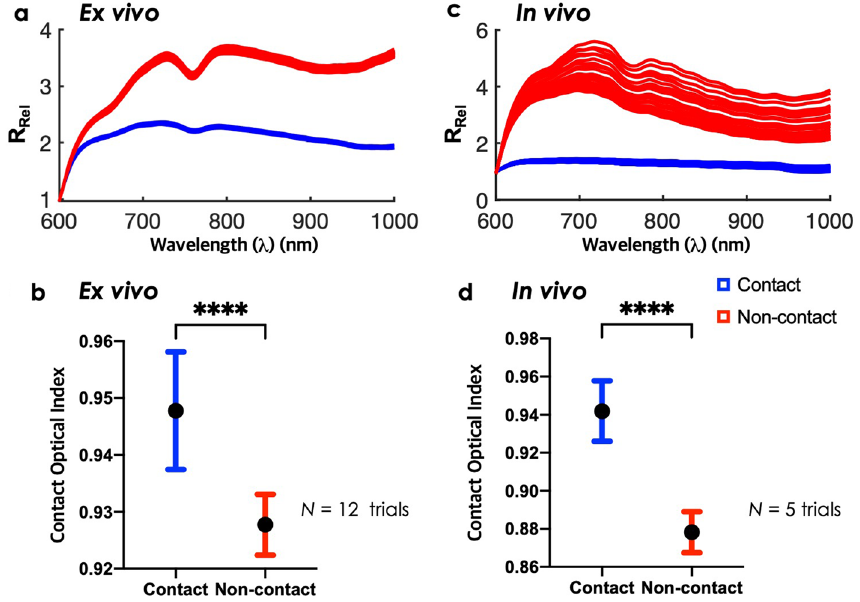
Figure 3. Catheter probe contact assessment ex vivo and in vivo. ( a ) Represents R Rel spectra of ex vivo contact (red) and non-contact (blue) measurements for 10 s. Black dashes denote contact optical index (COI) wavelengths. COI is described as follows: R Rel (764 nm)/ R Rel (730 nm). ( b ) Compares recorded COI between contact and non-contact. Bars are presented as mean and standard deviation (****P < 0.0001). ( c , d ) Repeated for in vivo demonstration.